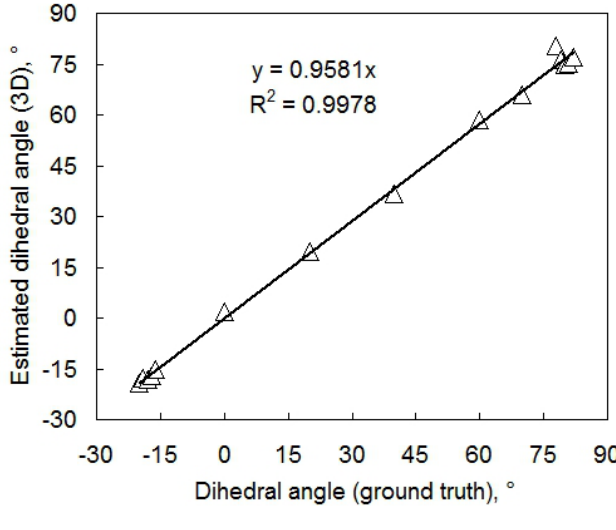
Figure 5. Validation of measurements of dihedral angle between a leaf that was positioned horizontally and a leaf that was precisely rotated. The dihedral angle between the two leaves was first measured and adjusted using a water-level inclinometer (x-axis). The measured angles are compared with the angles obtained by imaging and 3D computer reconstruction (y-axis). The negative and positive angles differ by the direction of the leaf rotation. The line represents a linear regression optimized by Microsoft